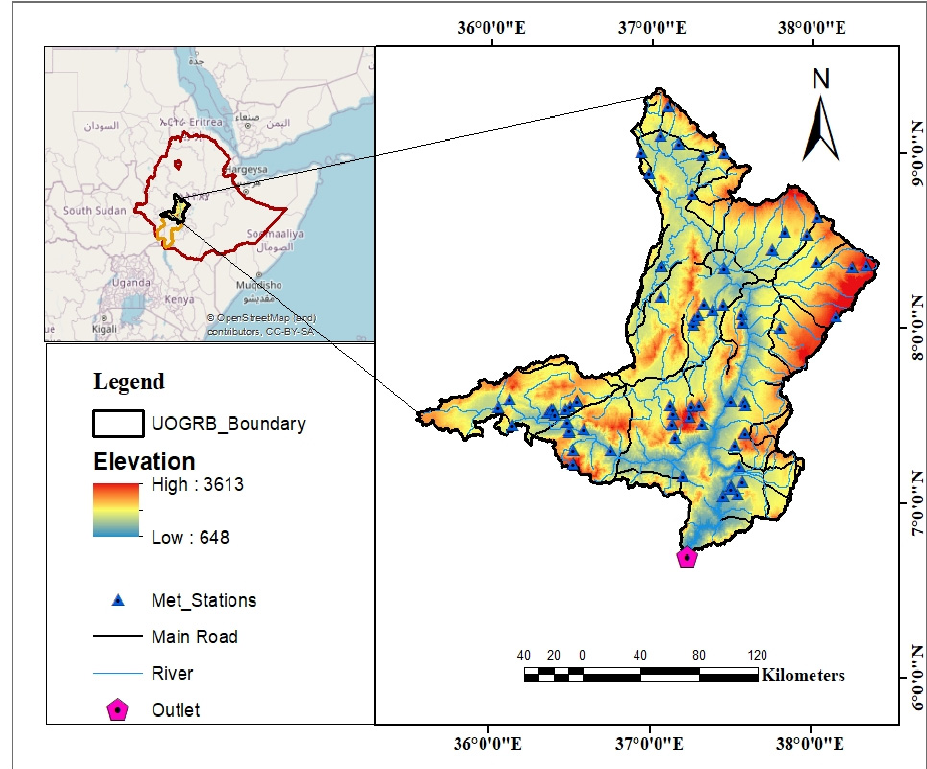
Figure 1. Location map of the Upper Omo–Gibe River basin.